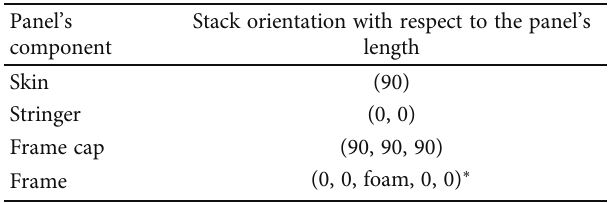
Figure 2: Damaged three-stringer PRSEUS panel being prepared for testing in Boeing Huntington Beach Test Lab [16]. Table 1: Three-stringer panel stack